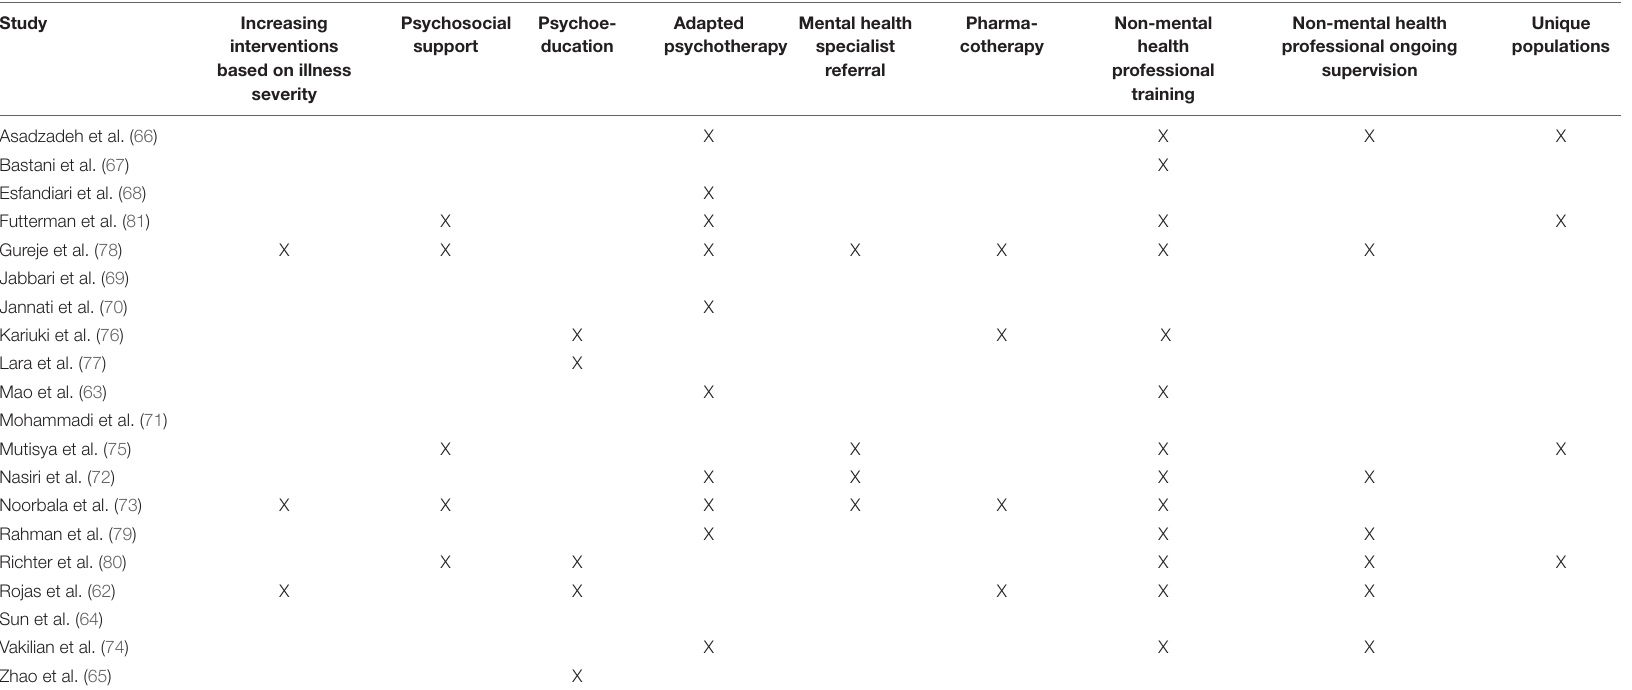
TABLE 2 | Intervention components of included studies by WHO recommended intervention component